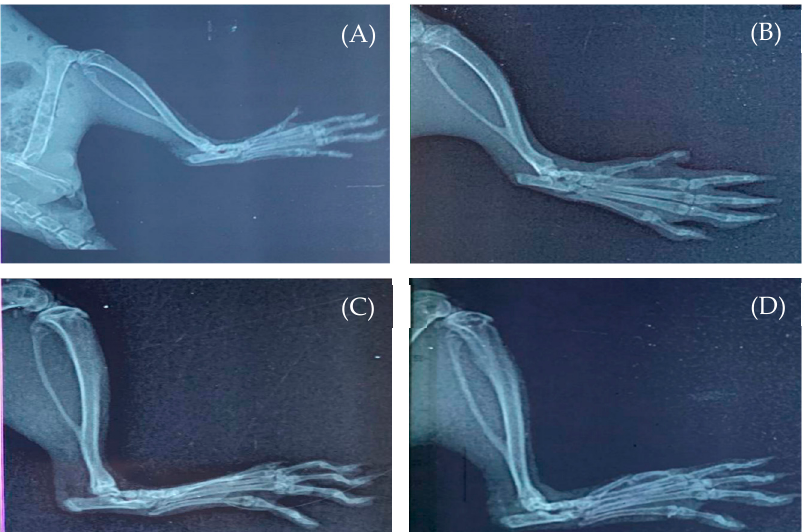
Figure 8. Radiological images of the right ankle joints of ( A ) normal control rats; ( B ) arthritic rats; ( C ) silver nanoparticle-treated rats; and ( D ) methotrexate-treated rats.